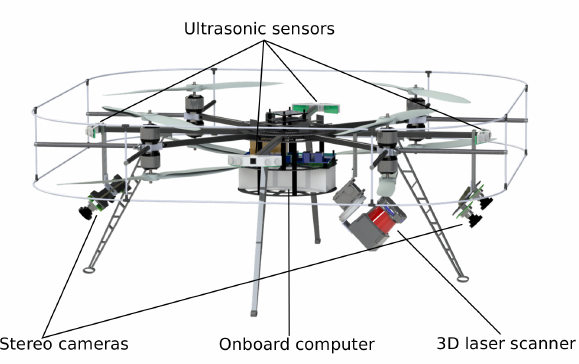
Figure 1: CAD model of our UAV with motor arrangement and sensor setup: continuously rotating 3D laser range finder, two stereo camera pairs and a ring of ultrasonic distance